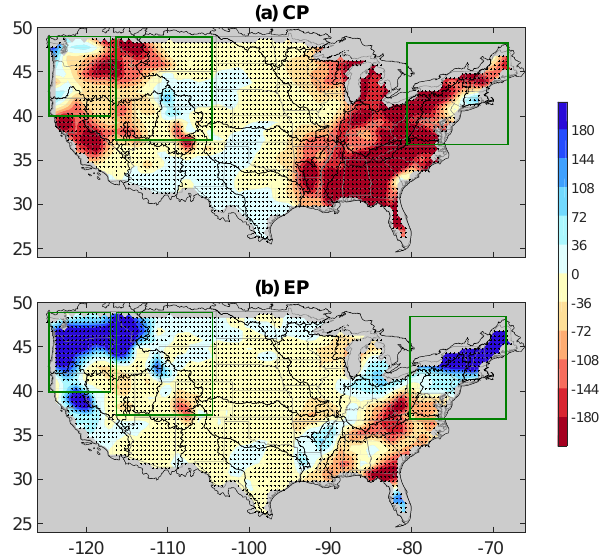
Figure 7. Same as Fig. 2, but using NCAR-CCSM4 model RCP4.5 output (unit: mm). + indicates results at 0.05 significance level based on a Monte Carlo